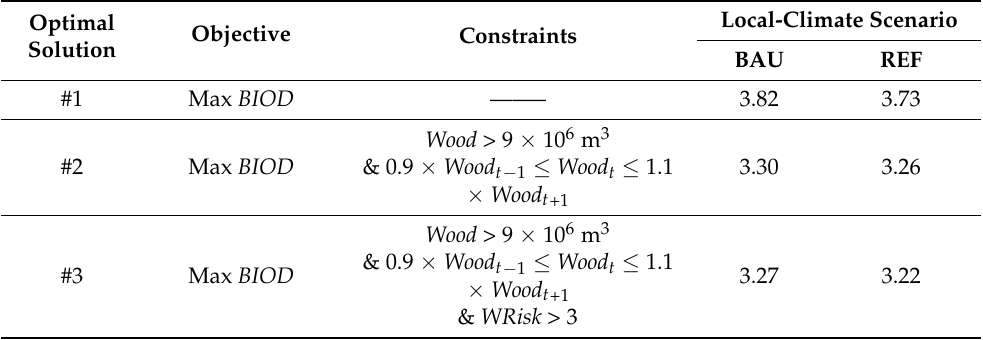
Table 5. Optimal LP solutions for biodiversity conservation under current (BAU) and changing (REF) local-climate